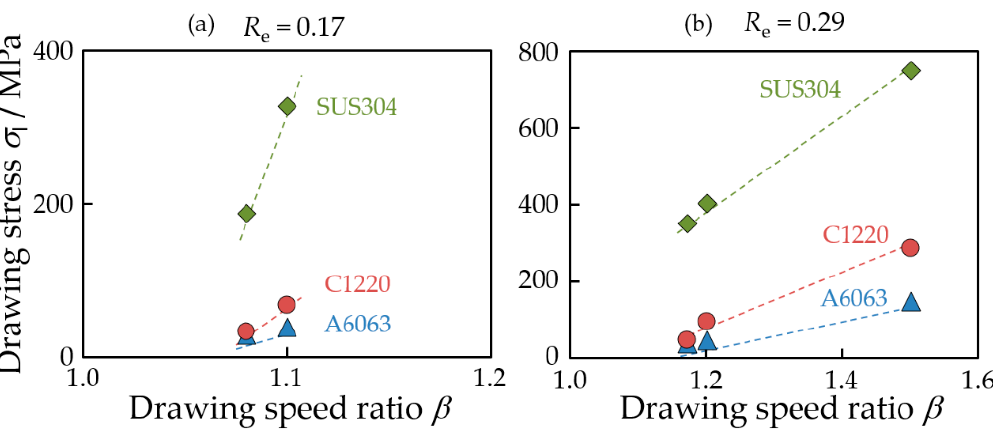
Figure 13. Drawing stress during drawing for each material. ( a ) Die reduction was 0.17 and ( b ) 0.29. The dotted lines indicate the eye guide.